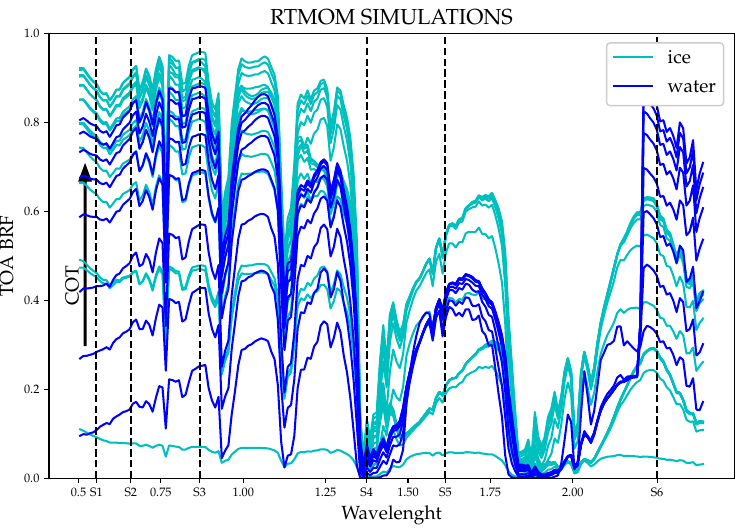
Figure 2. Results from the RTMOM simulations on ice (cyan) and liquid (blue) particle of different radius, with associated cloud optical thickness (COT) varying from 1 to 80. The dashed vertical lines represent the central wavelengths of the S3A/SLSTR bands from S1 to